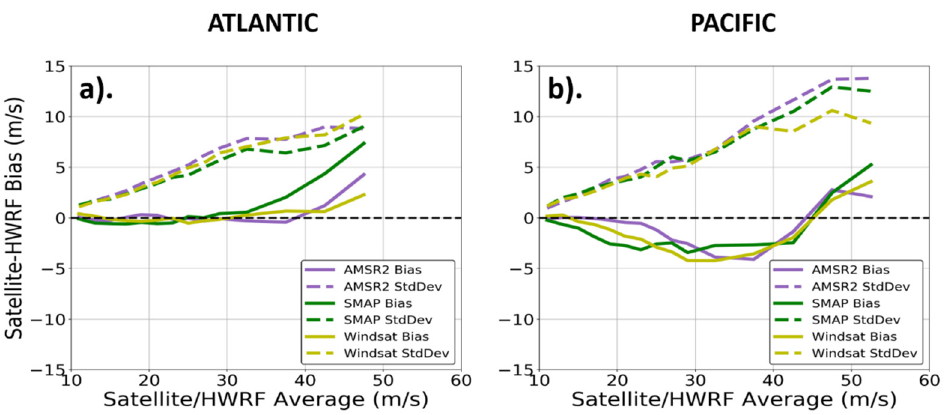
Figure 14. The results shown in Figure 13, except separated into the Atlantic ( a ) and Pacific ( b ) basins. Data from 11 storms were used to make the curves for the Atlantic, while data from 7 storms were used to make curves for the Pacific.